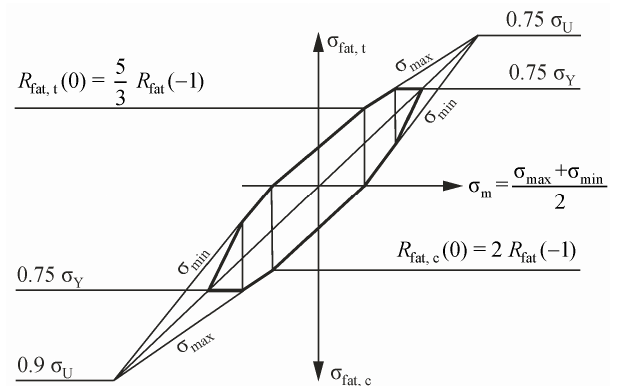
Figure 8. Dependence between the calculated fatigue strengths R fat ( − 1) and R fat ( χ ). Note: